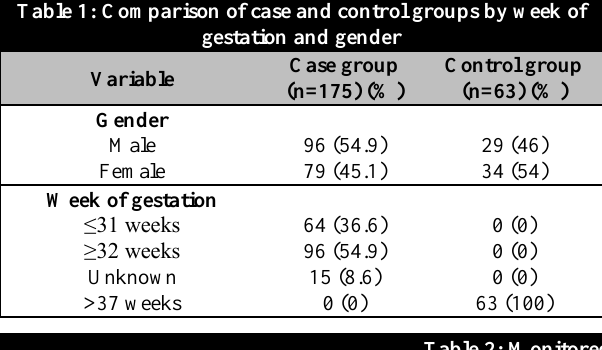
Table 2: Monitored problems in preterm